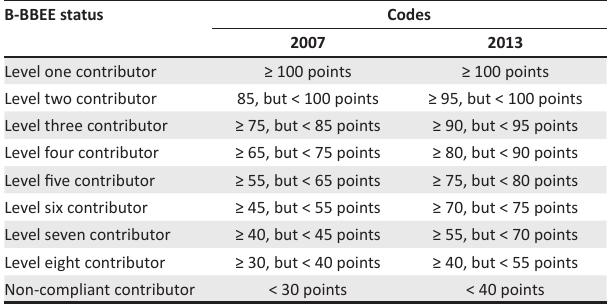
TABLE 3: Broad-Based Black Economic Empowerment compliance levels (2007 vs.